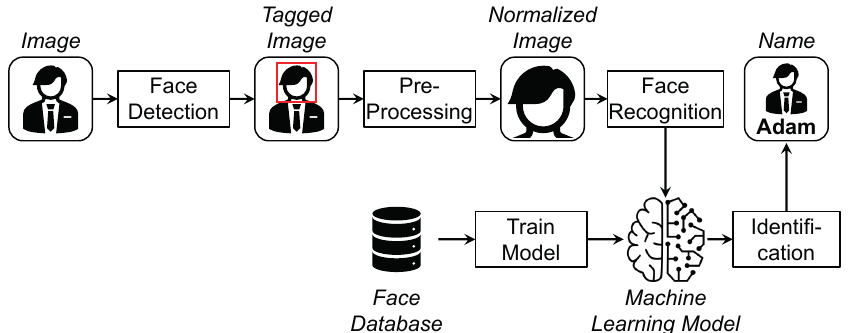
Figure 4. Workflow of a Face Detection and Recognition Based on Machine